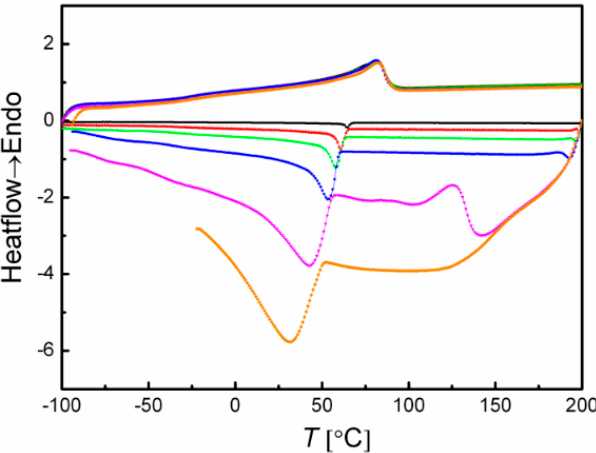
Figure 6. The second heating curves and the first cooling curves of DSC thermograms determined between − 100 °C and 200 °C for cPEVA20D20 with the same heating rate of 20 °C·min − 1 and different cooling rate of 1 °C·min − 1 (black), 5 °C·min − 1 (red), 10 °C·min − 1 (green), 20 °C·min − 1 (blue), 50 °C·min − 1 (pink) and 100 °C·min − 1 (orange).